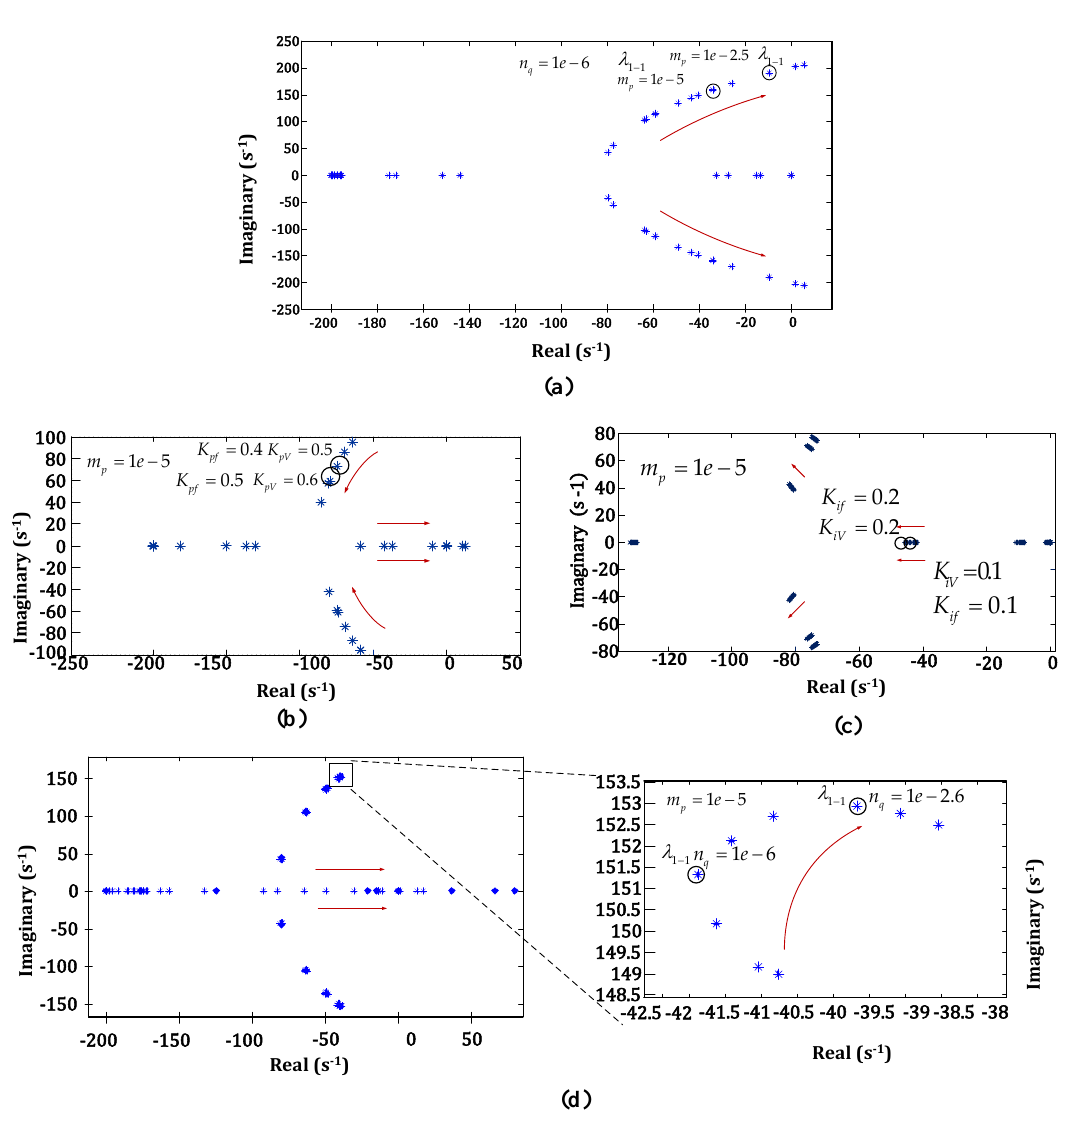
Figure 4: Observing effect of control gain variation on system stability through eigen traces: ( a ) effect of variation in m p ; ( b ) effect of variation in tertiary controller integral gains; ( c ) effect of variation in tertiary controller proportional gains; ( d ) effect of variation in n q.